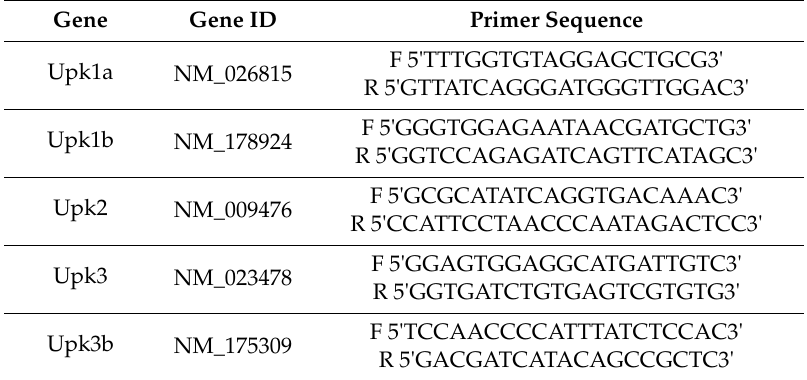
Table 3. List of primers used for real-time